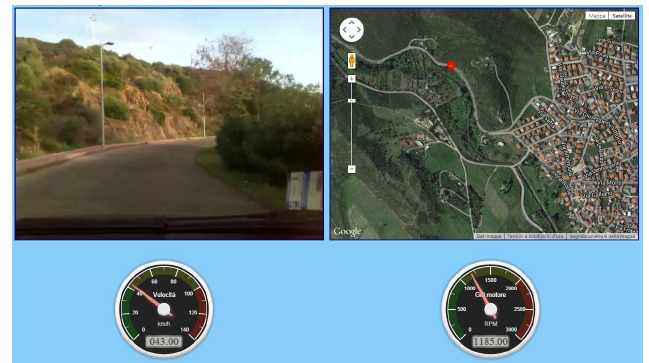
Figure 6. Screenshot of the web MIoT application with analog speed and rpm indicators.